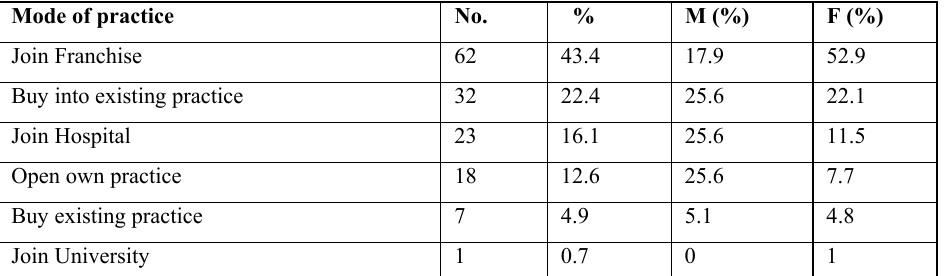
Table 9 : Number, percentages and genders of respondents who would join each mode of practices listed .